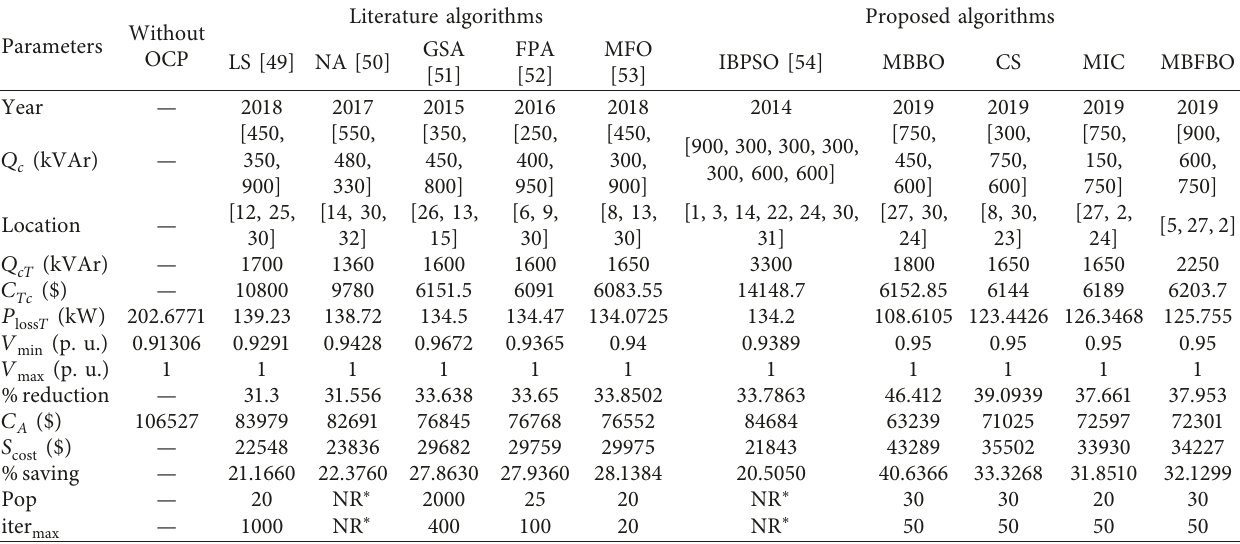
Table 8: Results and comparisons of IEEE-33-bus RDS without and with individual OCP technique.